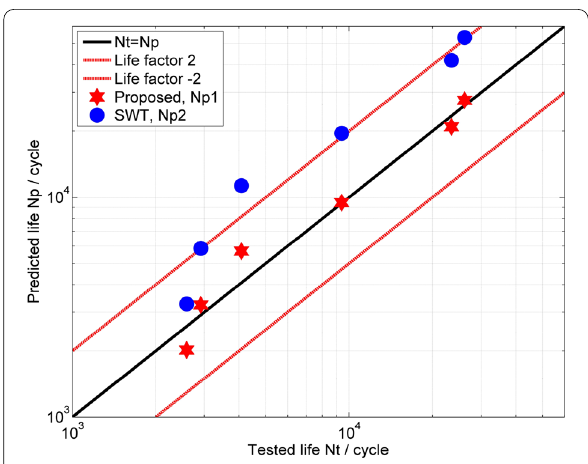
Figure 9 Predicted lives vs. the tested lives of